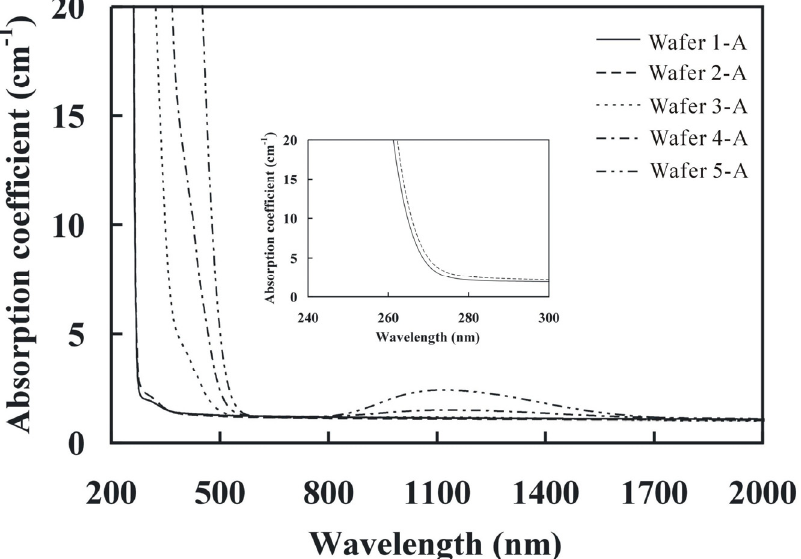
Figure 2. Absorption spectra of the as grown crystals